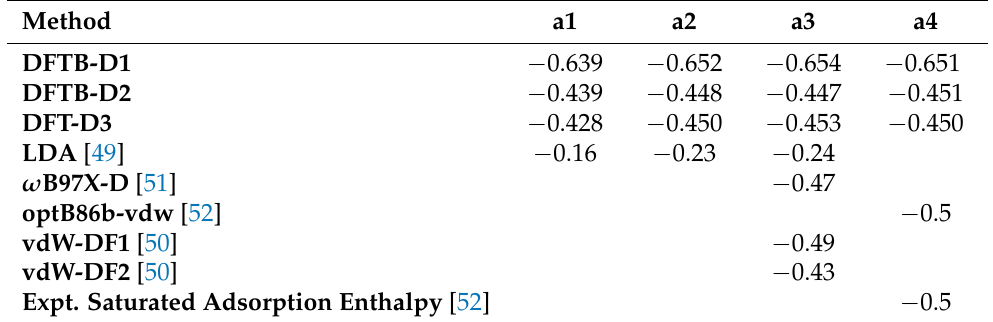
Table 2. Binding energies of benzene on graphene in eV. The experimental binding energy of a benzene molecule on a graphite surface is − 0.50 ± 0.08 eV